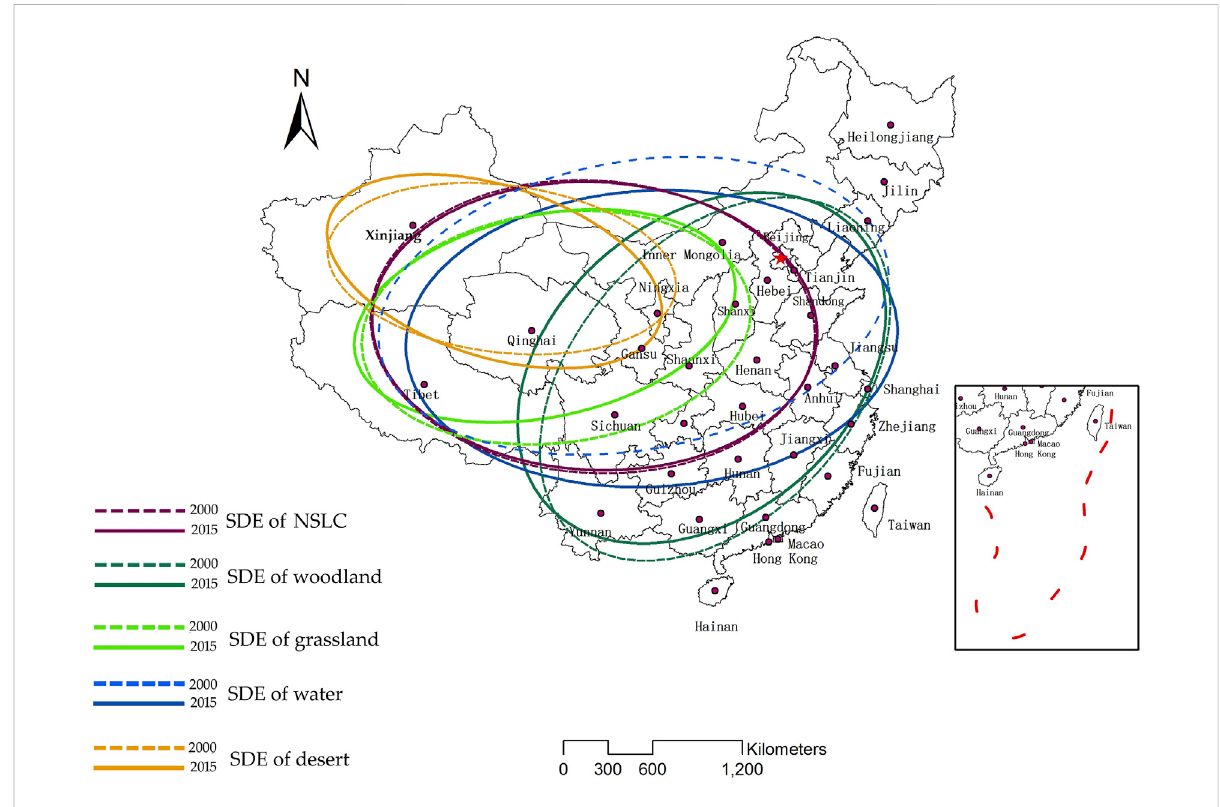
FIGURE 7 SDE spatial distribution of ecological space types from 2000 to